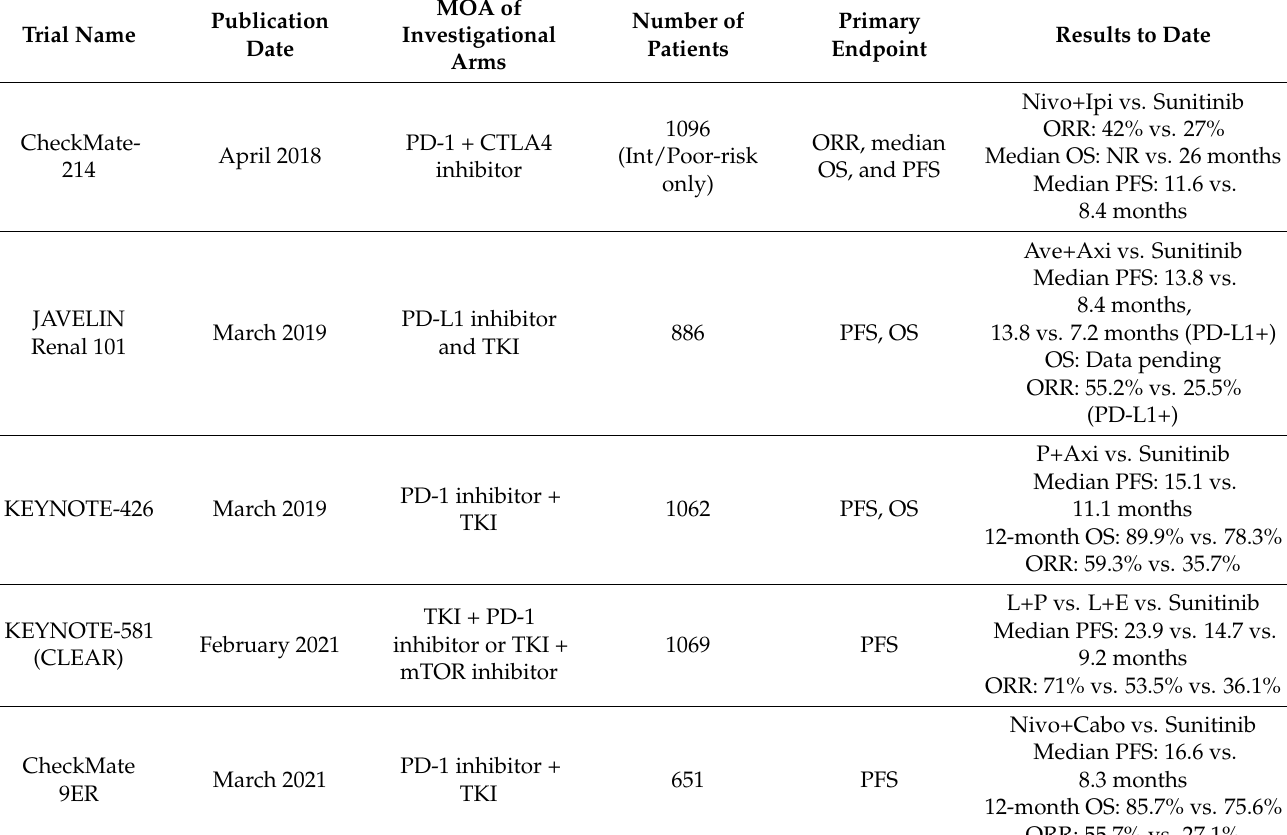
Table 1. Landmark first-line immunotherapy trials in metastatic